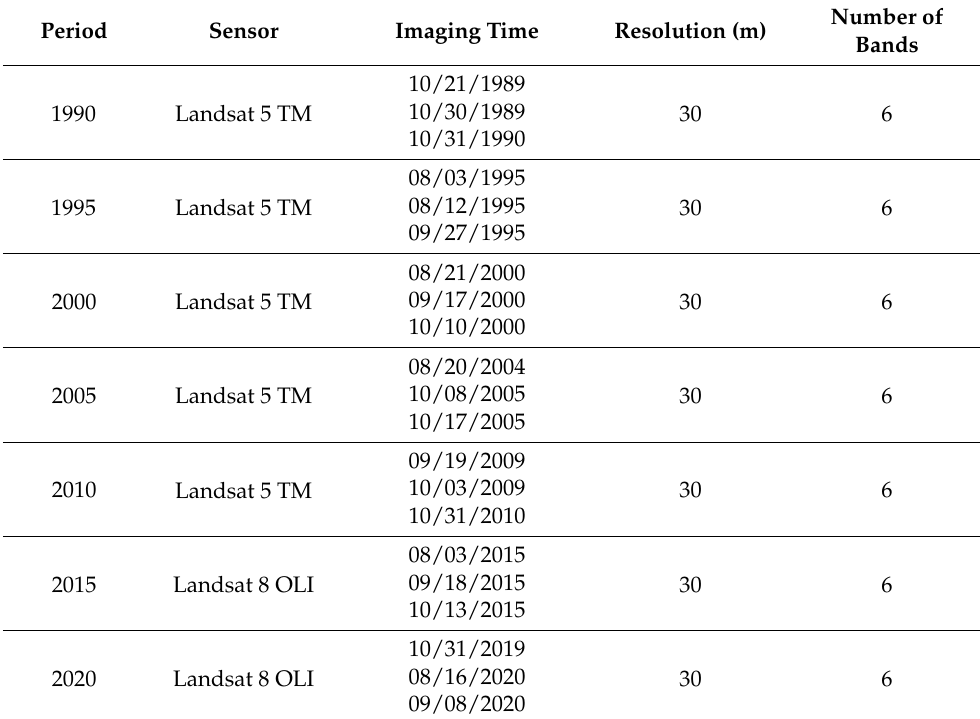
Table 1. Overview of Landsat data after band combination used in this study. (Date format: month/day/year). Period Sensor Imaging Time Resolution (m)